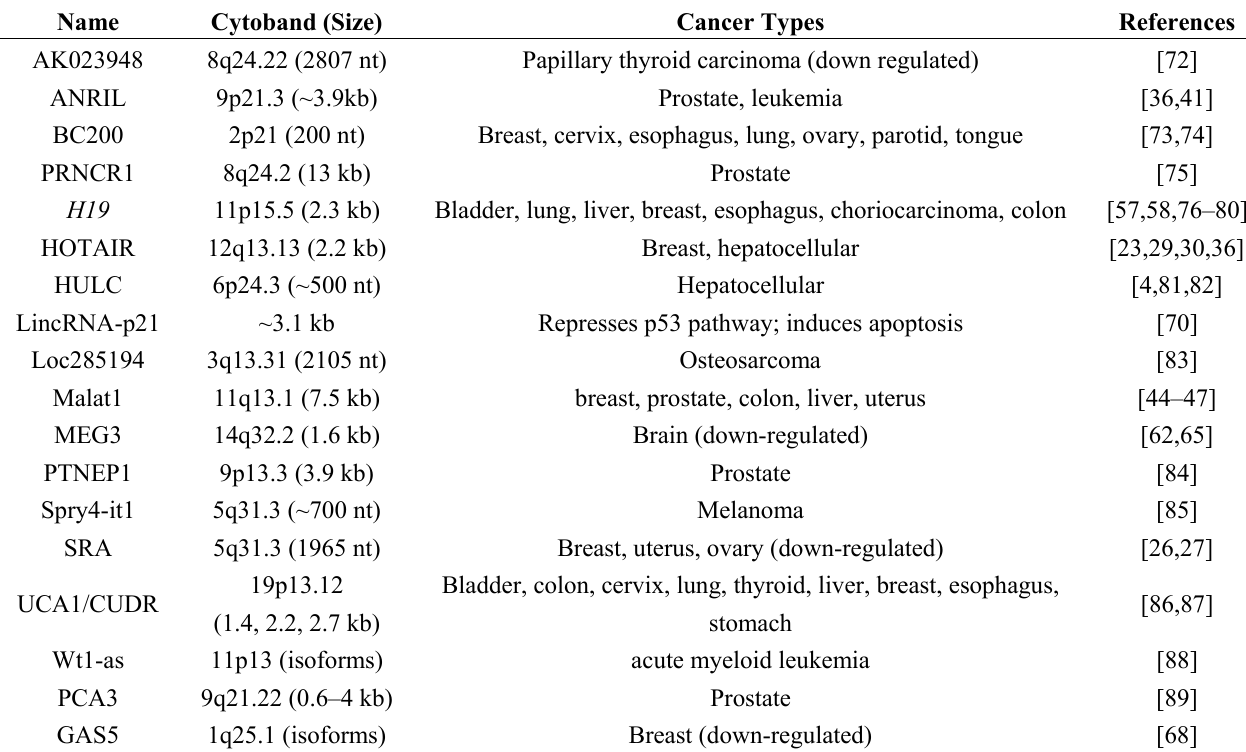
Table 1. Cancer associated lncRNAs (adapted from